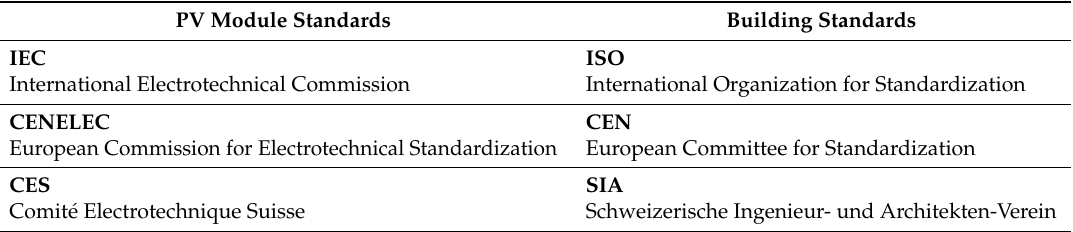
Table 1. Electrical and building reference standards for PV modules [69].